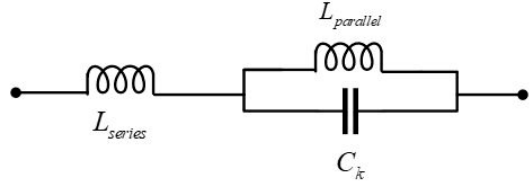
Figure 14. Pictorial representation of the rule for 𝑨 𝟑 .